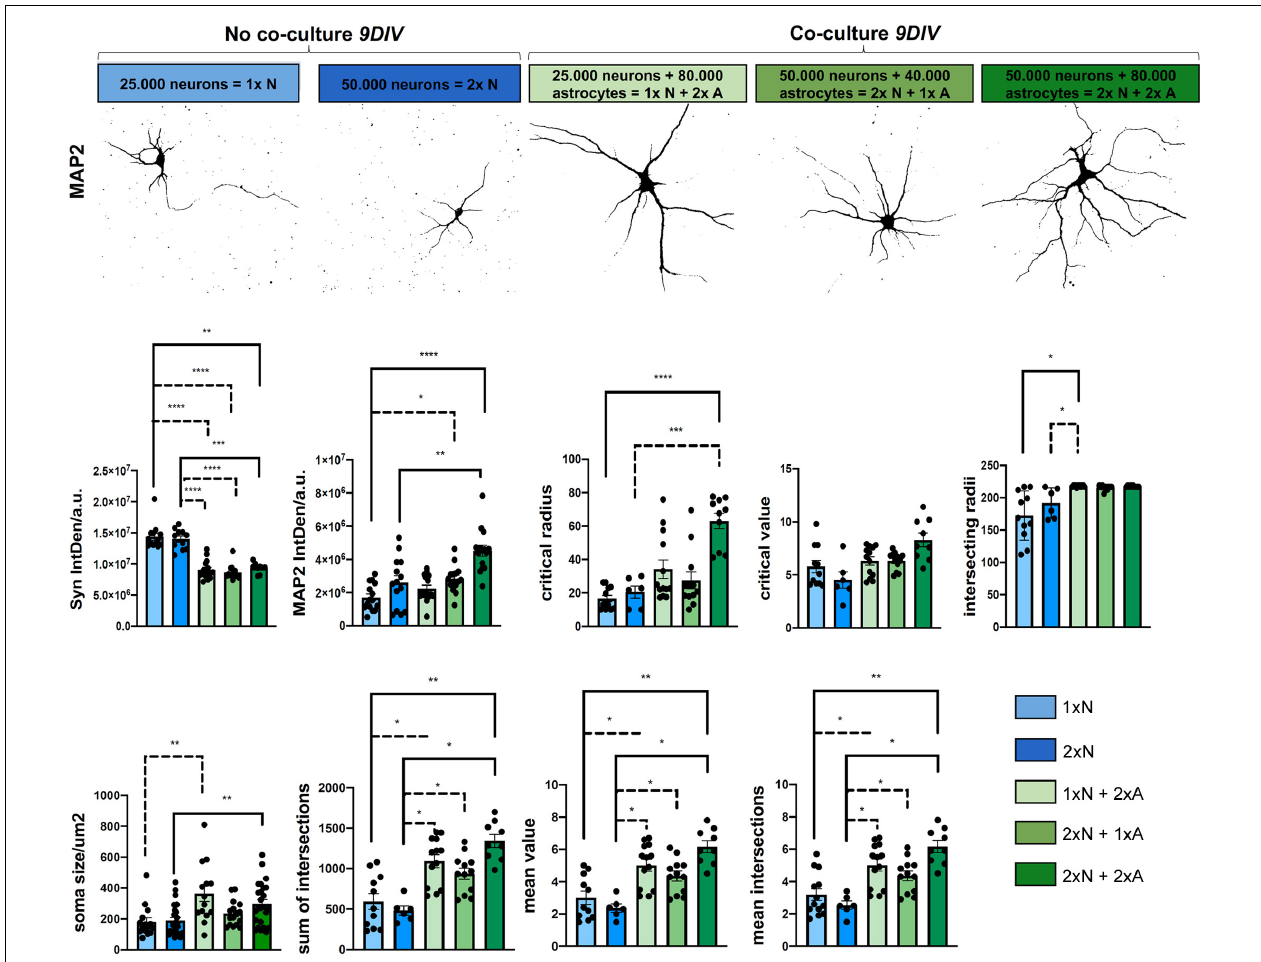
FIGURE 4 | Astrocyte-neuron co-cultures are superior to mono-cultured neurons in terms neuronal differentiation. Analysis of morphological metrics in neurons monocultures, without co-cultured astrocyte feeder cells and neurons co-cultured with astrocytes at 9 DIV, show increased differentiation in co-cultured neurons (upper row). Of note, the time point 9 DIV was chosen only for the comparison experiments of mono- vs. different co-culture conditions, since neurons in monoculture show a reduced live span in vitro . Experiments assessing effects in neuron-astrocyte co-cultures should be performed at 14 DIV , when neuronal differentiation in co-culture is optimal. Representative images were taken with a fluorescence microscope (Axiovert 200, Carl Zeiss, Göttingen, Germany). Shown are neurons for the MAP2 channel and displayed in false color for demonstration of the respective morphological hallmarks, scale bar = 50 µ m. Determination of IntDen of Synaptophysin signal per field and IntDen of MAP2 signal per field and of soma size are shown. Sholl metrics describe the degree of neuronal differentiation. Shown are critical radius (rc), and critical value (Nm), intersecting radii sum of intersections, mean value, and mean intersections as indicators of complexity and branching of the neurons. For better visibility, only significant differences are shown. Thus, N = 3 independent